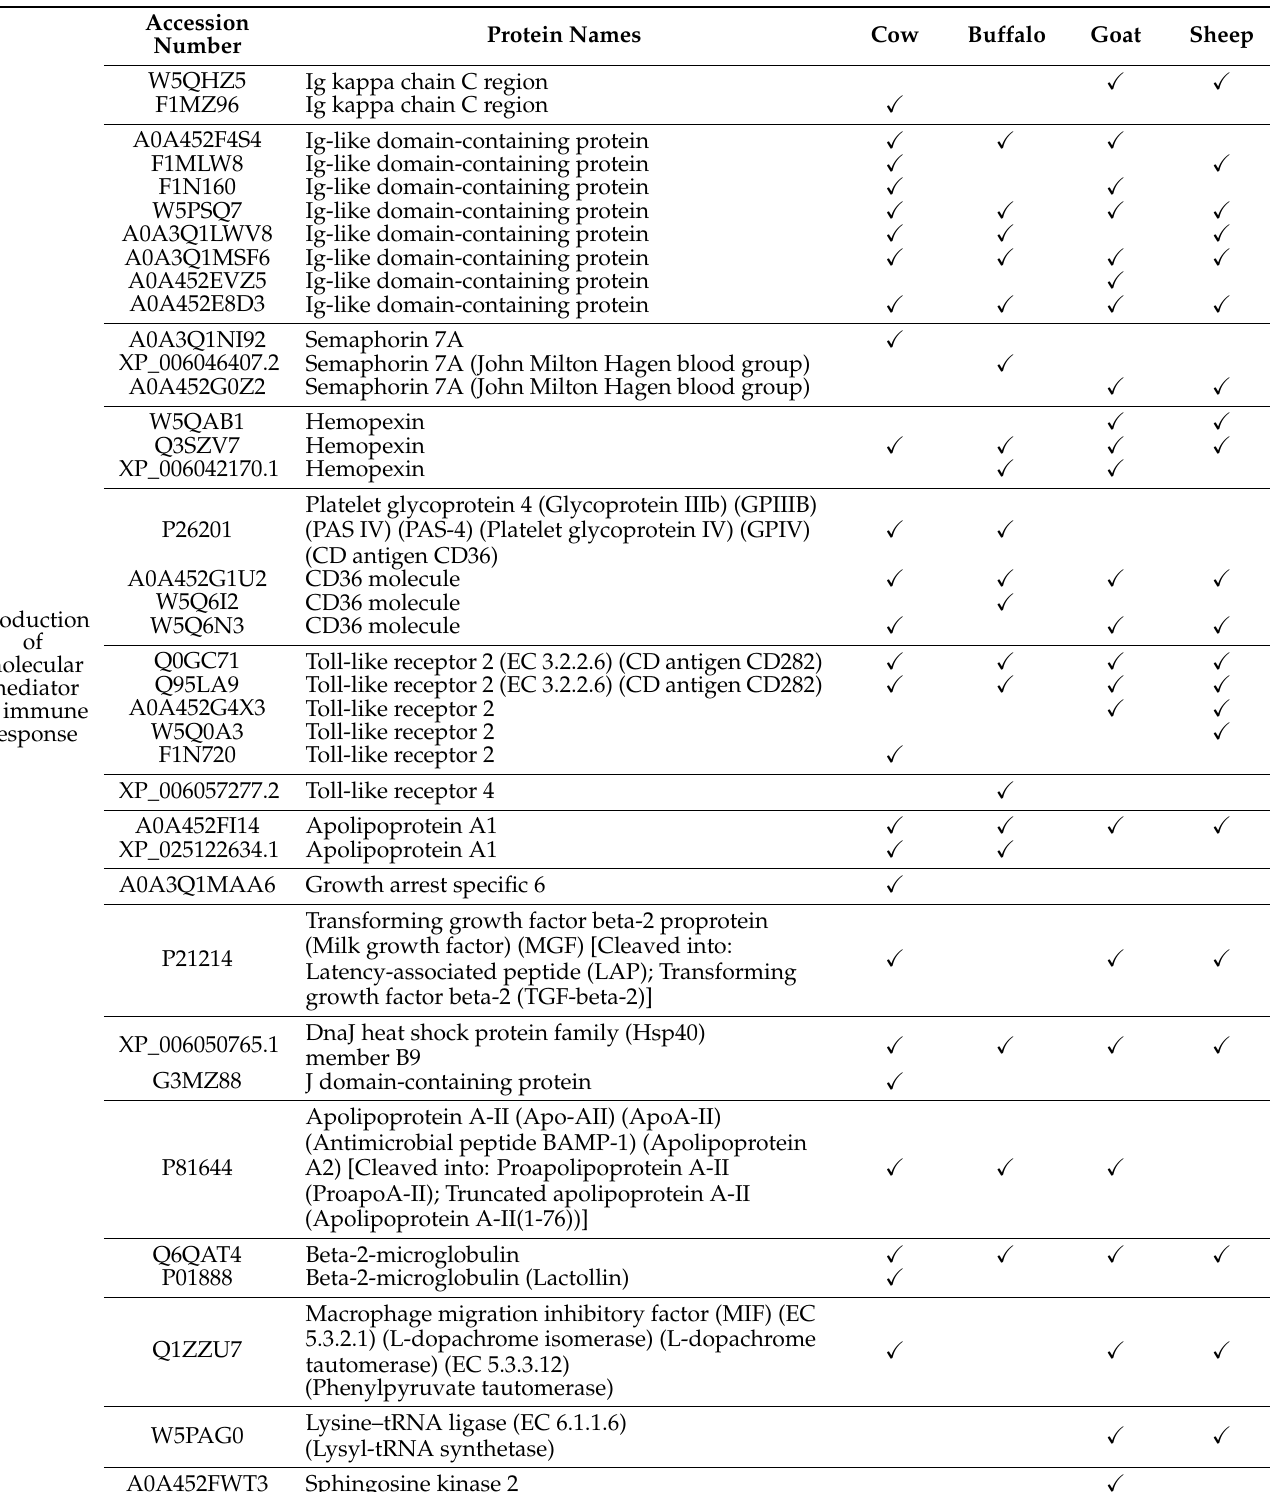
Table 4. Proteins identified in cow, buffalo, goat and sheep cream in the biological process GO terms “Production of molecular mediator of immune